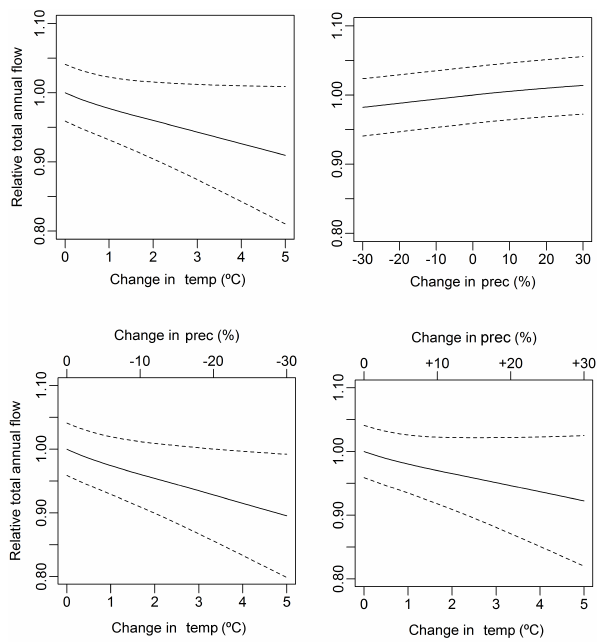
Figure 8. Projected changes in total streamflow (relative to current long-term average) under changing climate conditions. The top two panels show the sensitivity to changes in temperature and precipi- tation when they are varied independently. The bottom panel shows sensitivity to changing temperature in conjunction with decreasing (left panel) and increasing (right panel) precipitation. Dashed lines represent 95% confidence bounds from bootstrap resampling.